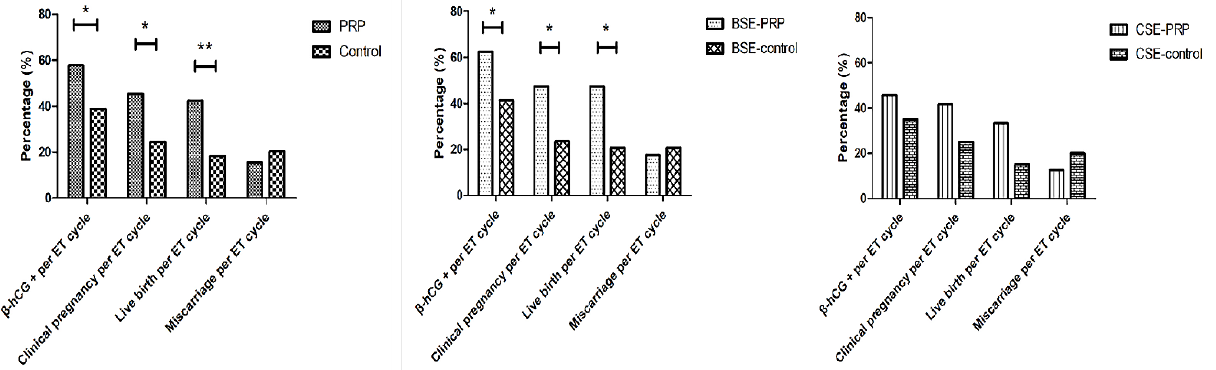
Figure 2. Comparison of the outcome variables in different groups, including the β-hCG-positive rates, clinical pregnancy rate, live birth rate, and miscarriage rate per ET cycle in the PRP ( n = 64), control ( n = 54), blastocyst-stage-embryo (BSE) ( n = 40), BSE control ( n = 34), cleavage-stage-embryo (CSE) ( n = 24), and CSE control ( n = 20) groups.* Statistically significant: p < 0.05, ** Statistically significant: p < 0.01.